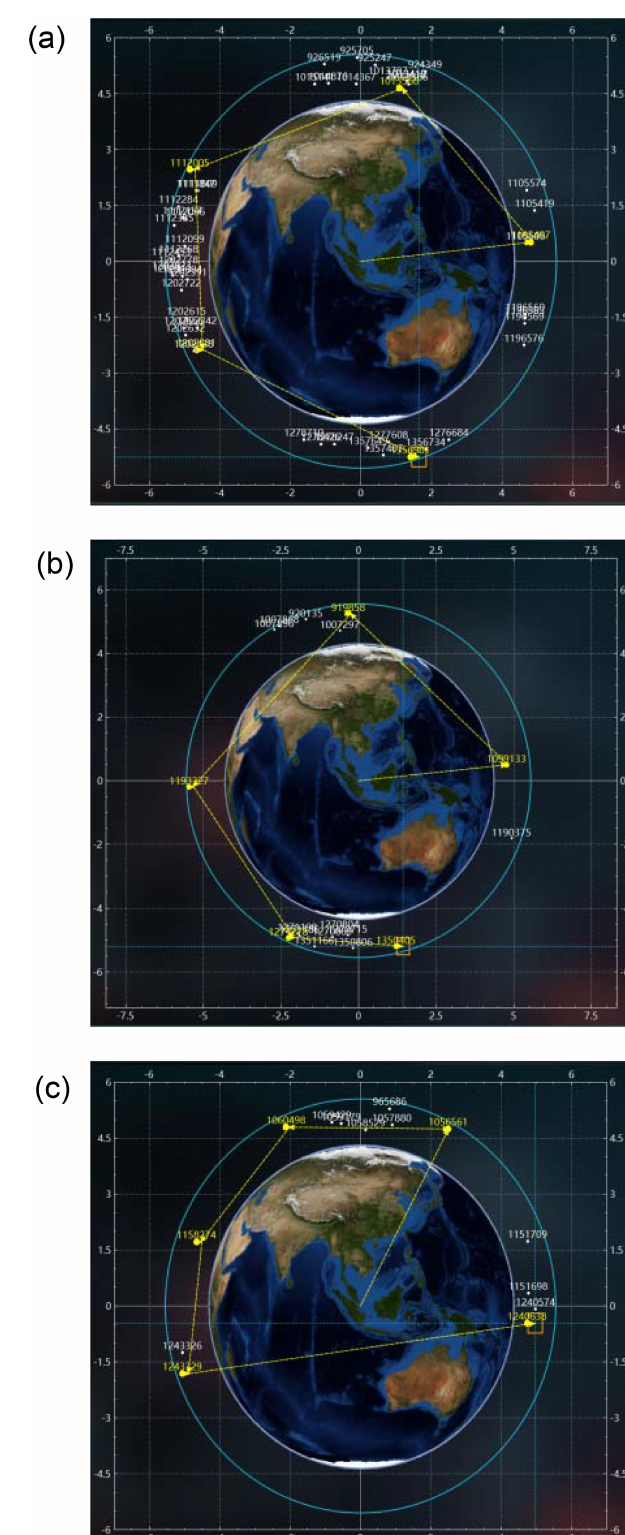
a lot of stars, (b) with a reasonable number of stars and (c) with a few